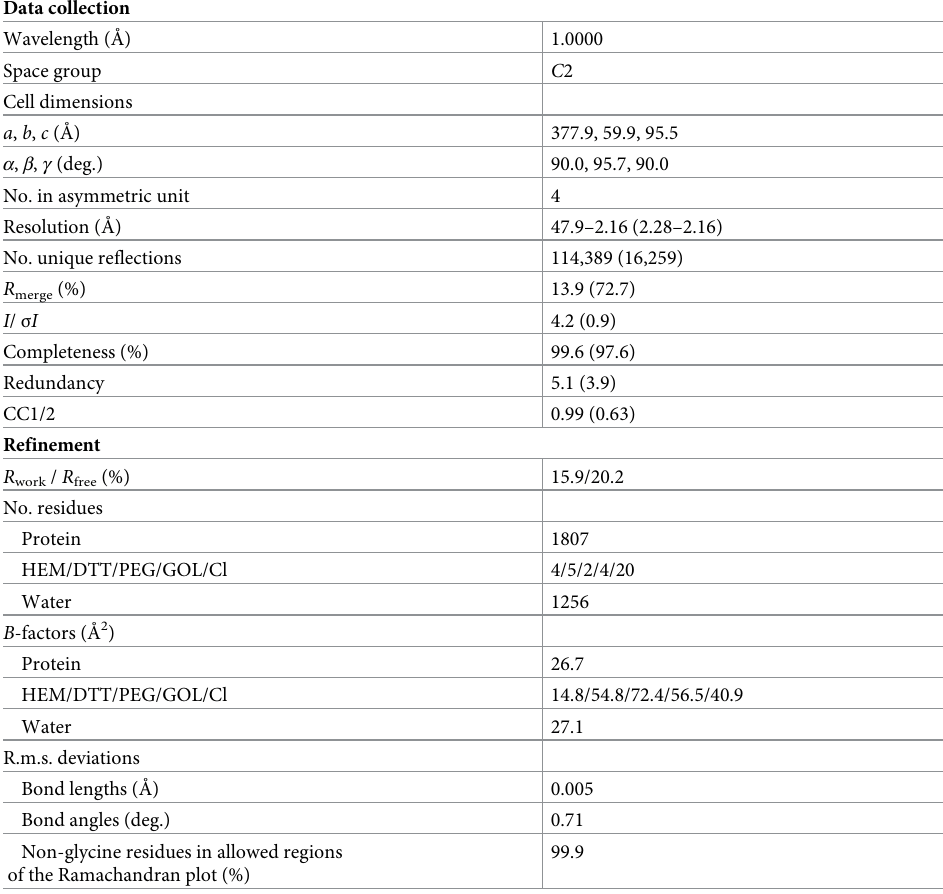
Table 1. Crystal data, data collection and structure refinement of CYP BM3 M11 mutant in complex with